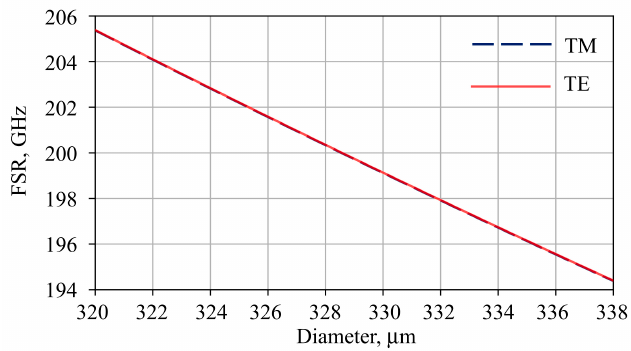
Figure 3. FSR as a function of a microsphere diameter for transverse magnetic (TM) and TE modes.